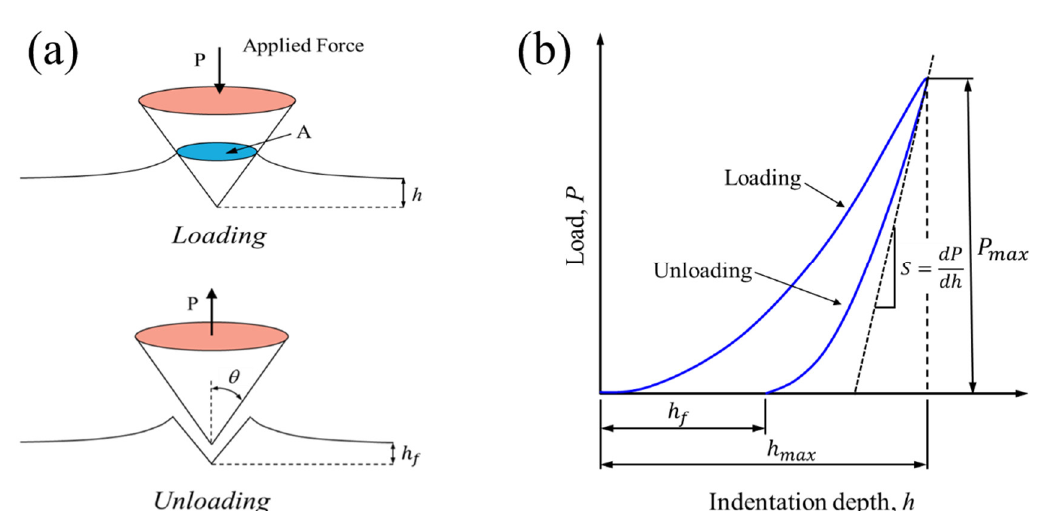
Figure 2. ( a ) A schematic representation of loading and unloading in indentation tests. ( b ) Typical indentation load–depth curve with important measured parameters.